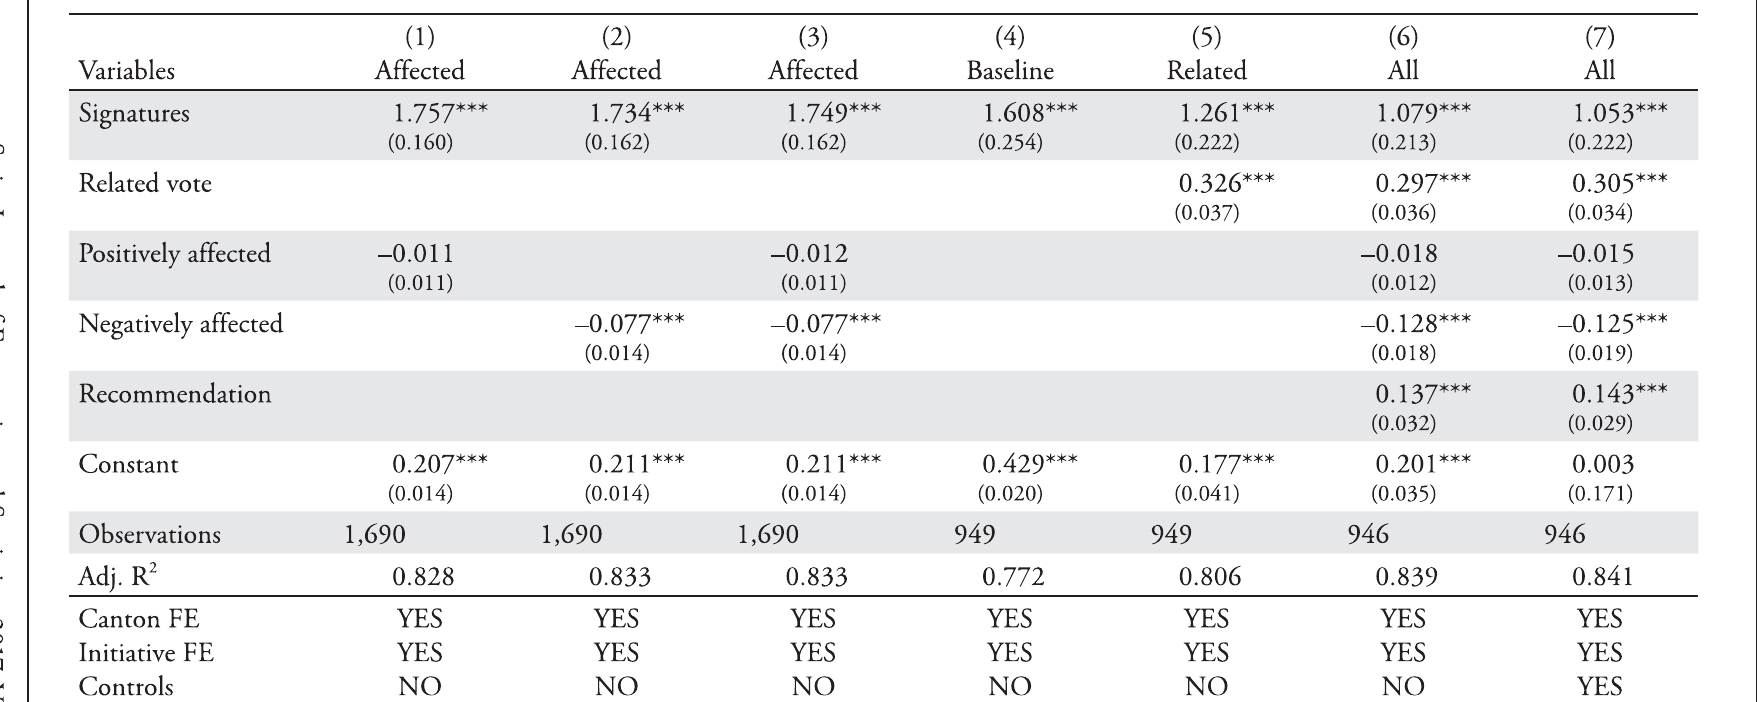
Table 4: Preferences Proxies: Affected Cantons and Related